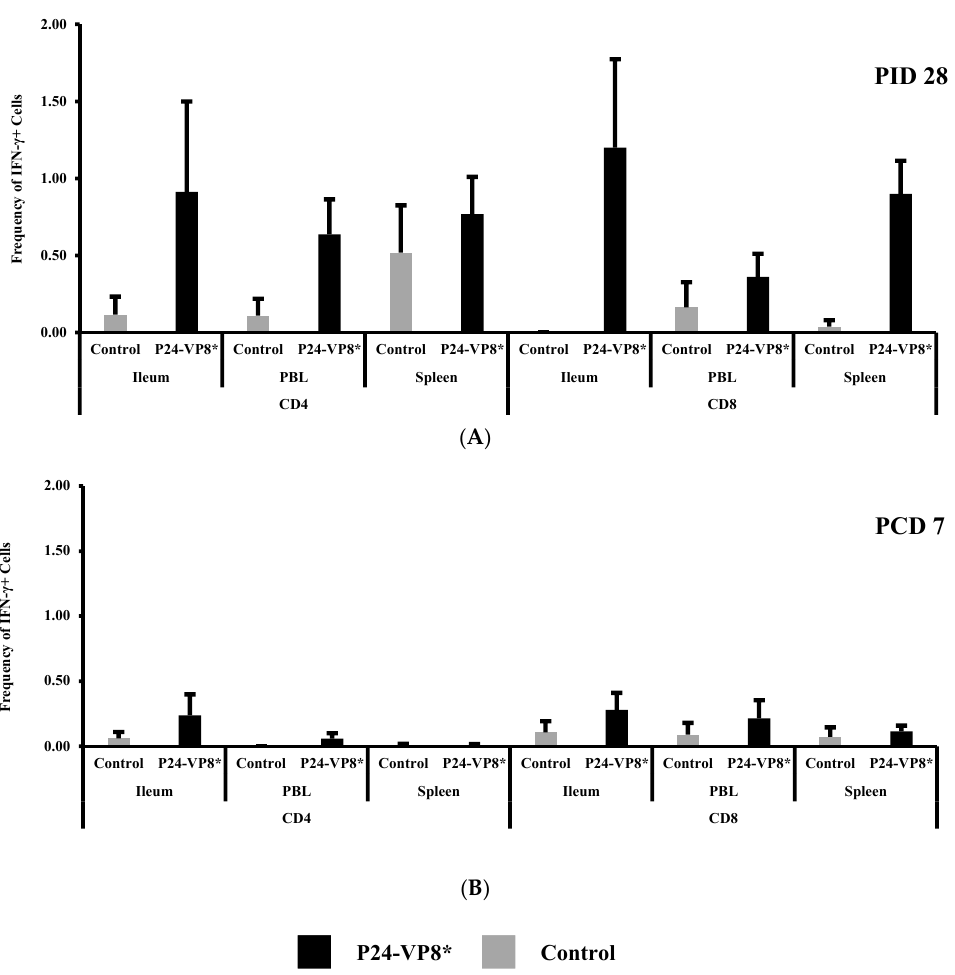
Figure 3. Frequencies of IFN- γ + CD8 + and IFN- γ + CD4 + T cells in ileum, peripheral blood (PBL), and spleen at PID 28 ( A ) and PCD 7 ( B ). Two-way ANOVA followed by Multiple t -tests were carried out for comparisons. ( n = 3–8; p < 0.05). There were no significant differences.